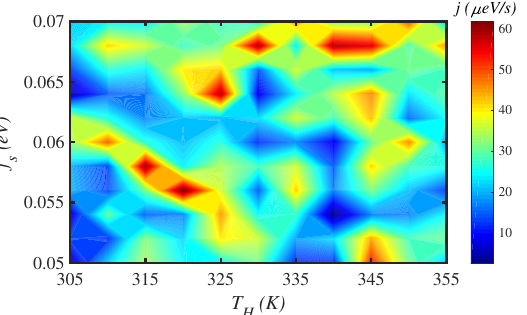
Figure 5. Color map of the variation of energy flux, j , through a N = 150 site protein chain with respect to the influence of the solvent parameter, f s , and of the temperature of hot source, T H , when the protein is subjected to a fixed temperature difference, ∆ T = 5 K, between its two